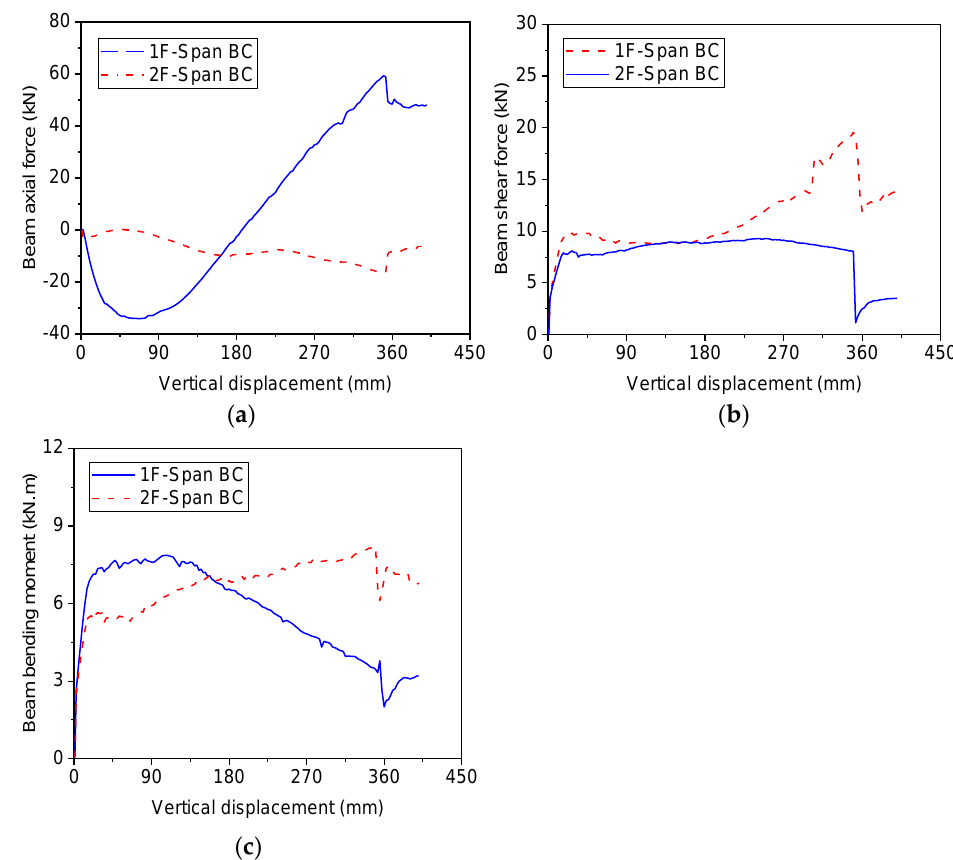
Figure 12. Behaviour of beams at different storeys of two-storey frame: ( a ) axial forces in beams; ( b ) shear forces in beams; ( c ) bending moments in beams.